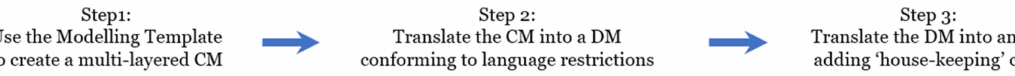
Figure 16. Steps in the of the development